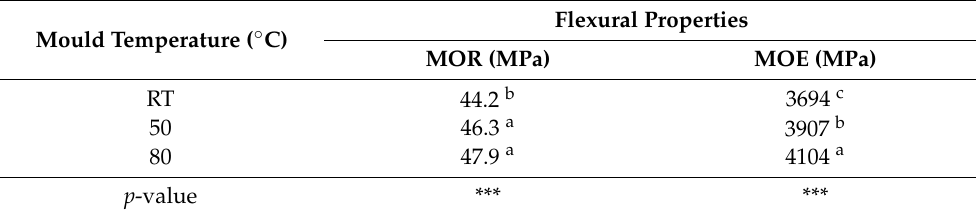
Table 10. Summary of the least significant difference (LSD) test results for the mould temperatures based on flexural properties of the PP/OPT composites.